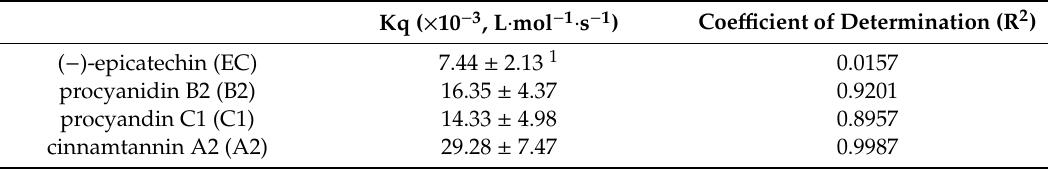
Table 1. Quenching constant (Kq) for interaction of EC, B2, C1 and A2 with BSA calculated using the Stern–Volmer